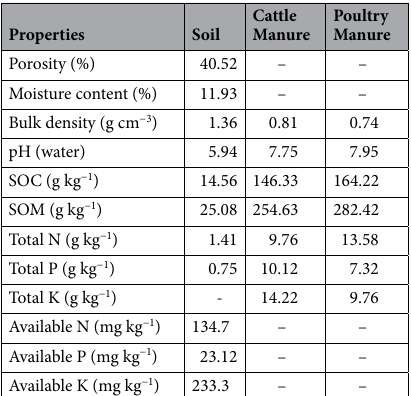
Properties Soil Porosity (%)